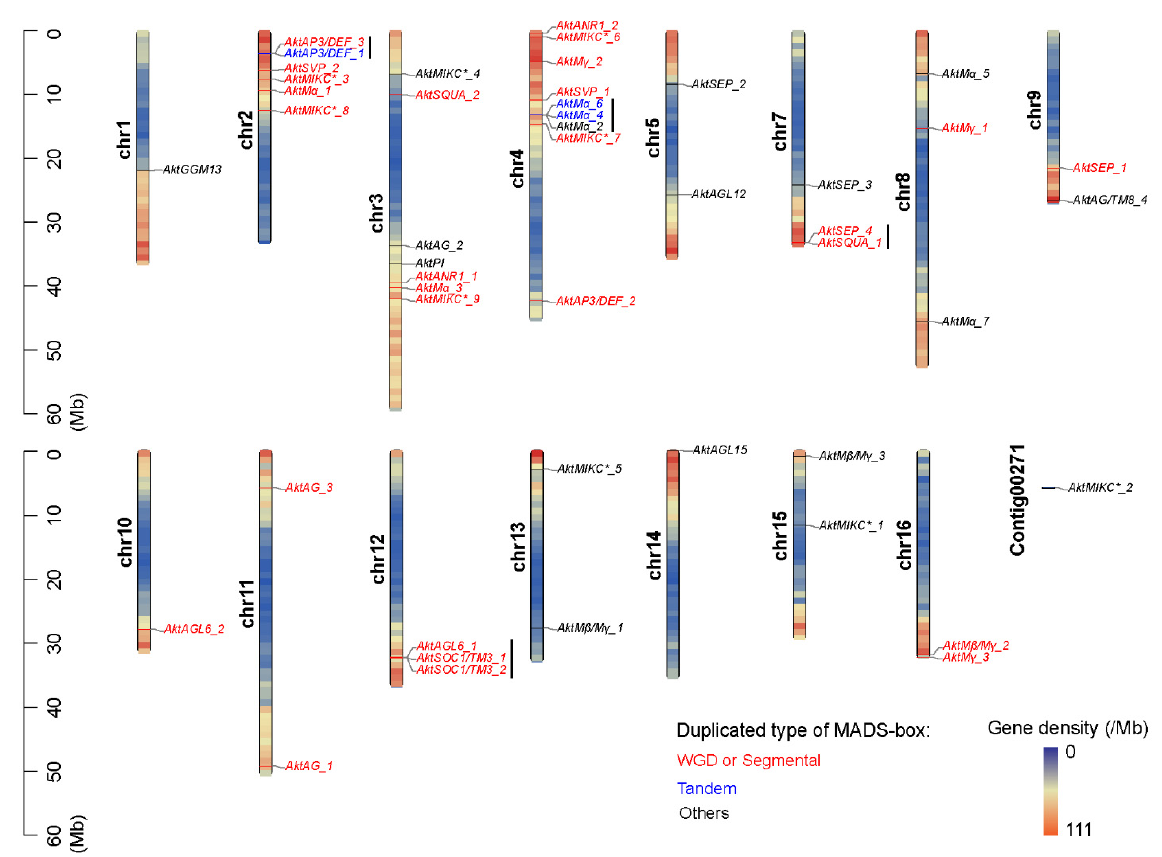
Figure 3. Physical position and duplicated type of MADS-box genes in the A. trifoliata genome. WGD or segmental duplicated-type genes are marked in red font, tandem duplicated-type genes are marked in blue font, and other dispersed or proximal duplicated genes are marked in black font. The black line to the right of the gene names represents cluster loci.